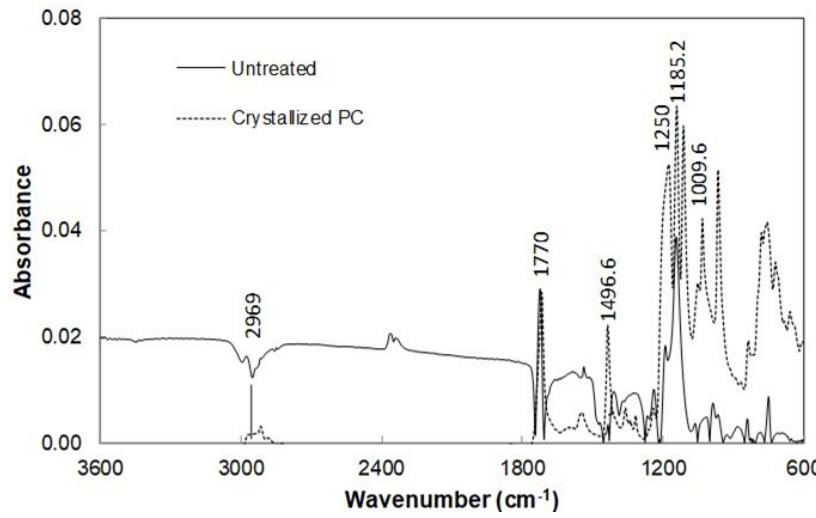
Figure 3. Fourier-transform infrared (FTIR) absorption data for crystallized and as received sur-